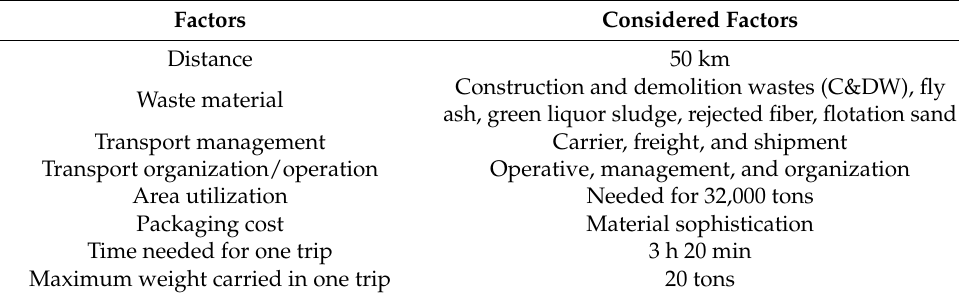
Figure 1. Flow chart illustrating the steps involved from raw material transportation to the 3D printed product. Table 1. Transportation cost calculation